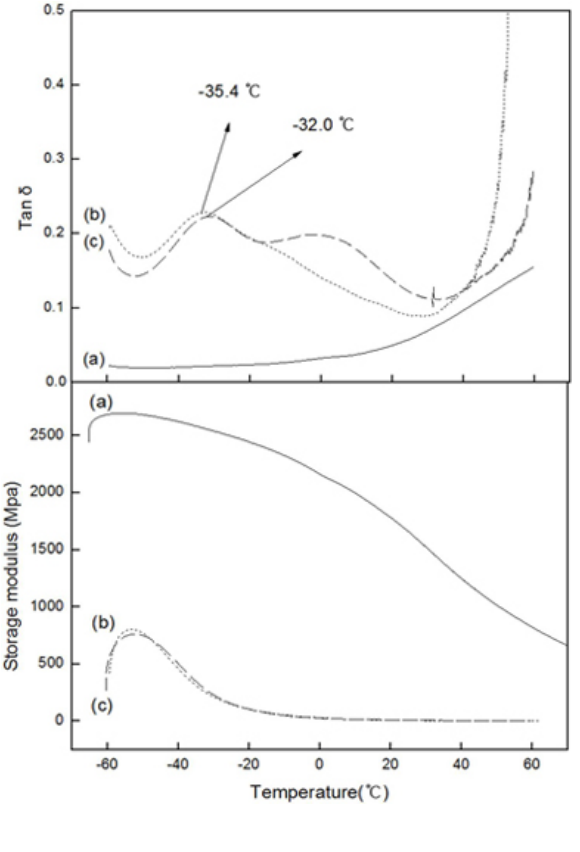
Figure 5. Tan δ and storage moduli versus temperature fort ( a ) PE; ( b ) PED and ( c )